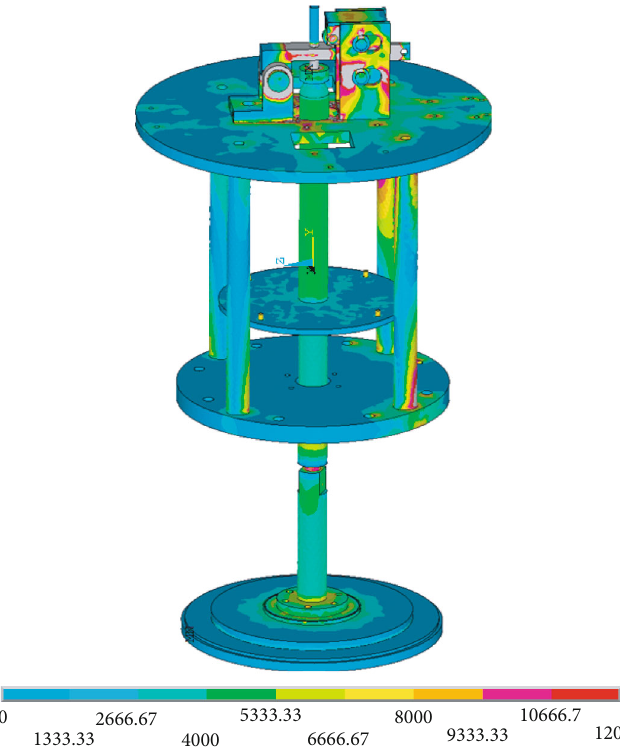
Figure 2: The cloud map of von Mises stress for the mechanism.